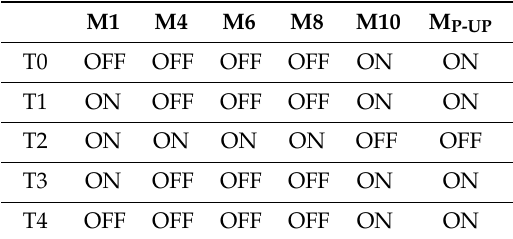
Figure 12. Simulation of voltage vs. time during a cycle. Table 1. Rectifier Switching State during Cycle.